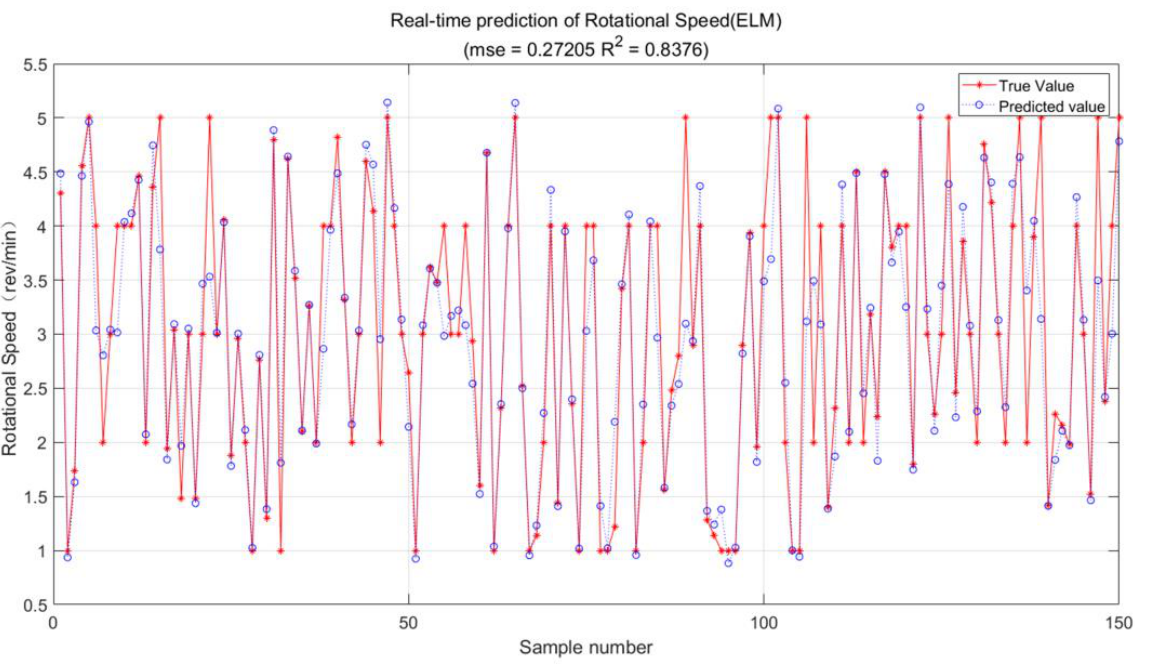
Figure 9. Real-time prediction of the rotational speed.